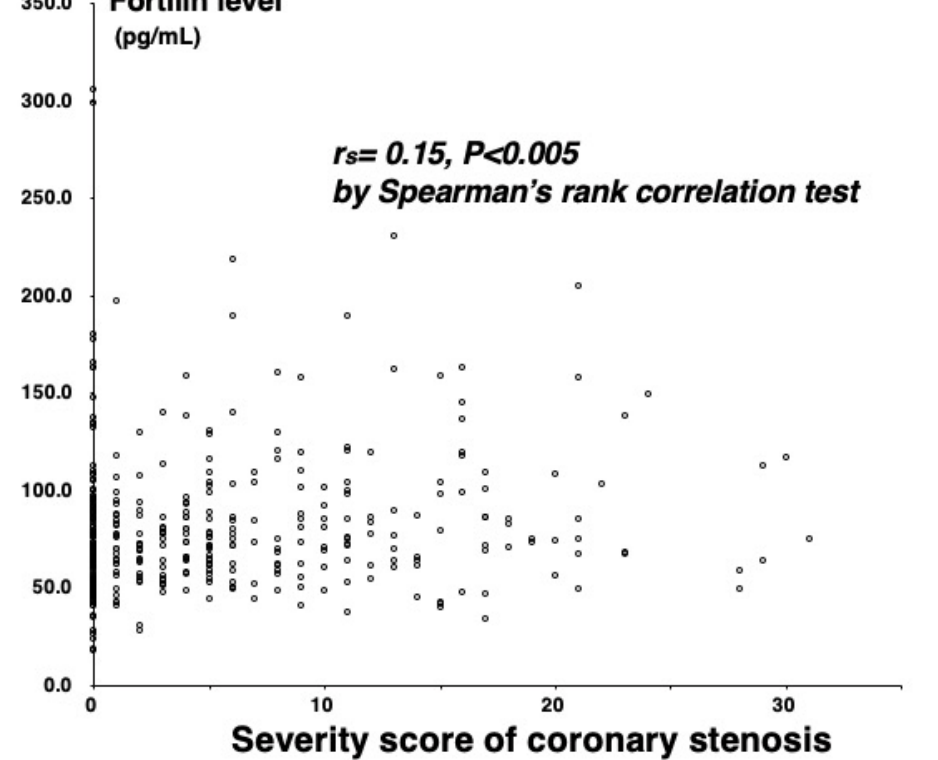
Figure 1. Fortilin levels and CAD or the number of stenotic vessels. Fortilin levels were higher in the CAD(+) group than in the CAD( − ) group ( p < 0.02) ( left ), and they were the highest in the 3VD group ( p < 0.005) ( right ). The central line and box show the median and 25th to 75th percentiles.